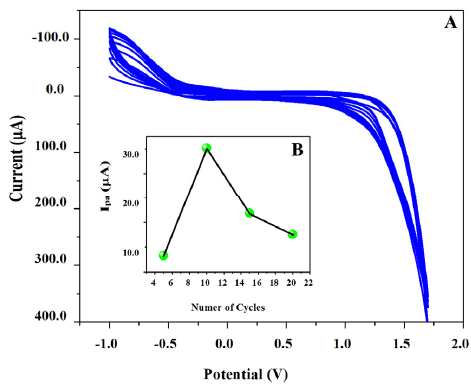
Figure 4. Cyclic voltammograms of 0.1 M glycine layered on carbon paste electrode with 10 elec ‐ tropolymerized cycles with a 0.1 Vs − 1 scan rate ( A ). Plot of the number of CV cycles vs. I pa ( B